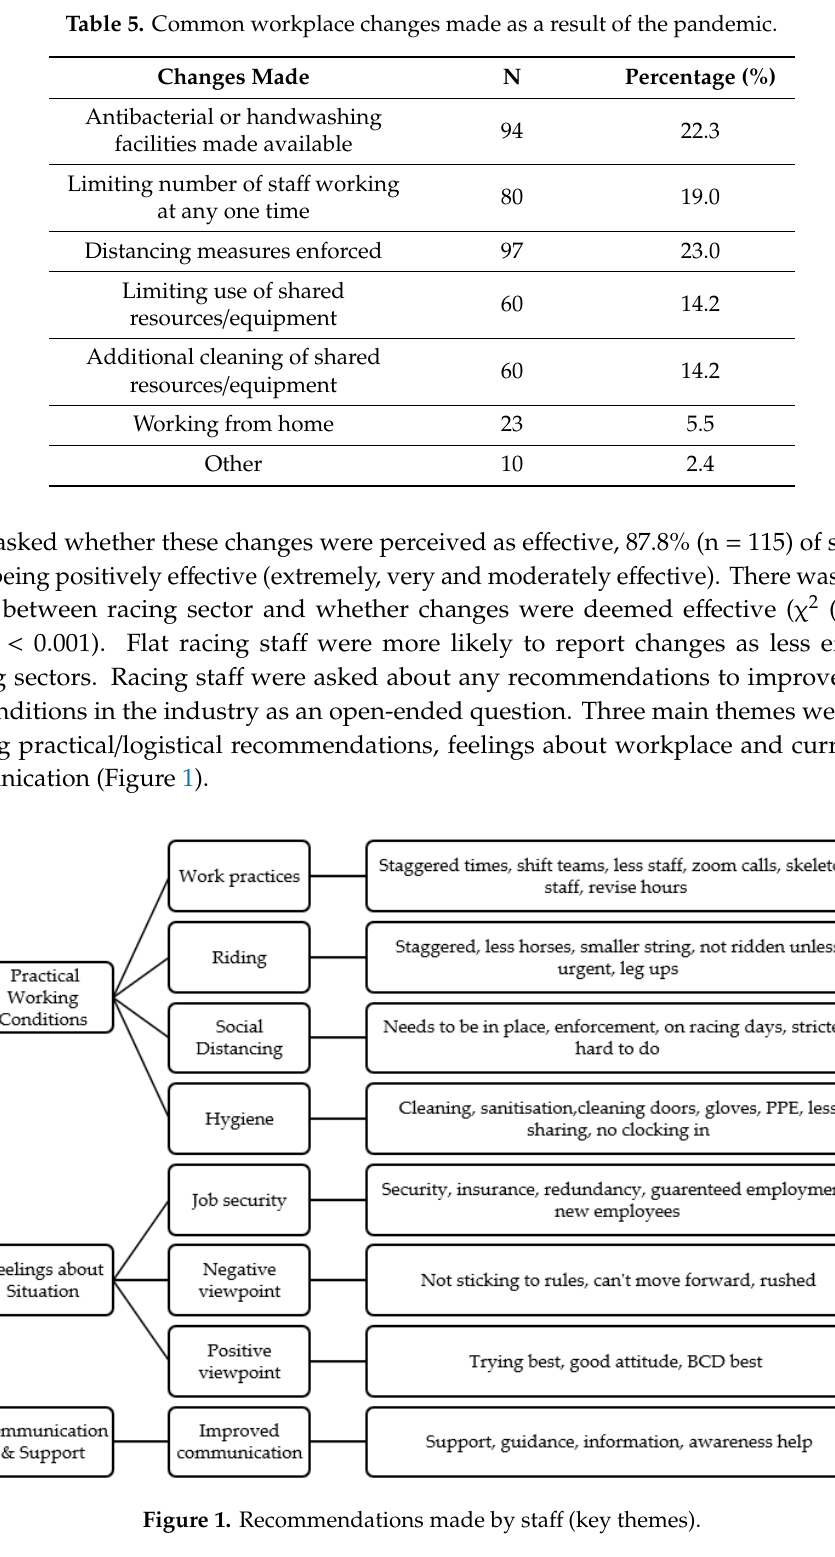
Figure 1. Recommendations made by staff (key themes).